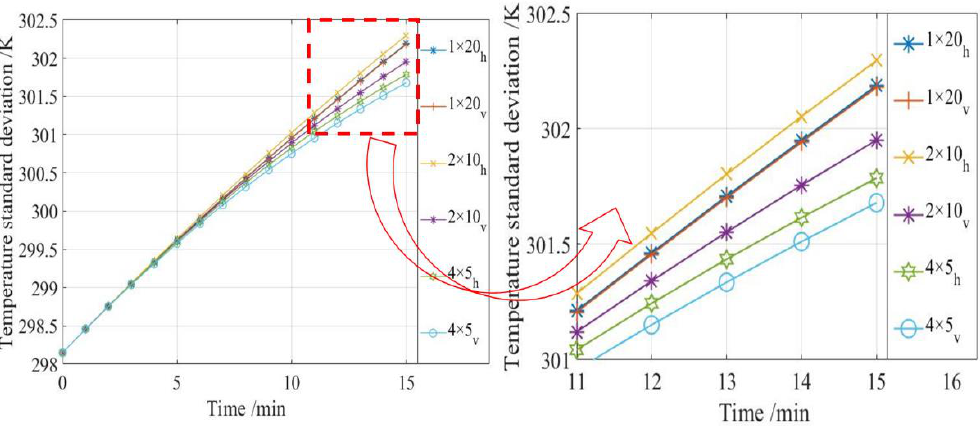
Figure 9. The MaxT variation in the layout schemes over time.